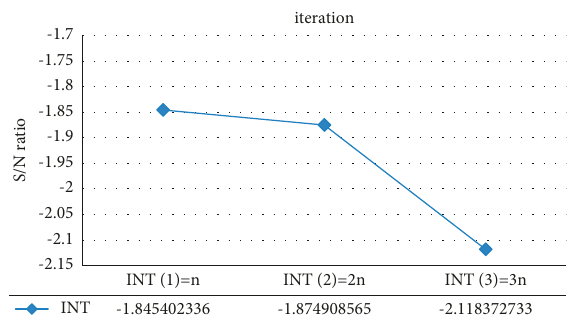
Figure 4: Graph of the average S / N ratio for each level of the int factor of the ABC algorithm in solving the model.